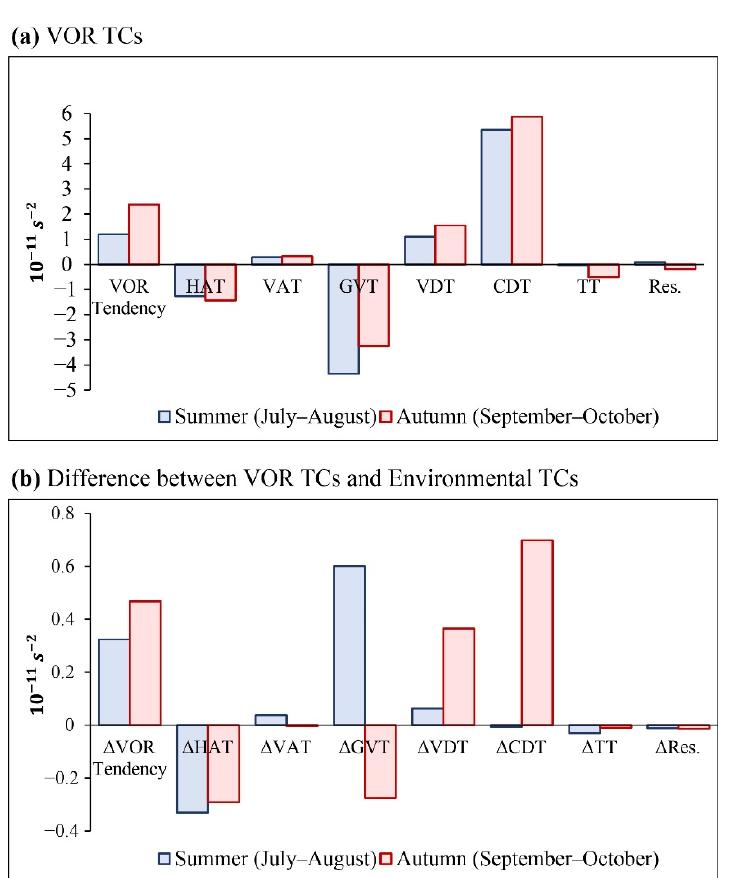
Figure 5. Different terms (unit: 10 − 11 s − 2 ) in the vorticity equation at 850 hPa, averaged within the annulus area of 2°–8° from the TC center during the intensification period: ( a ) VOR TCs and ( b ) difference between VOR TCs and Environmental TCs. In ( a ), VOR Tendency means the vorticity tendency ( ∂ζ ) for VOR TCs; in ( b ), ∆ VOR Tendency means ∂ζ for the difference between VOR TCs ∂ t ∂ t and Environmental TCs.